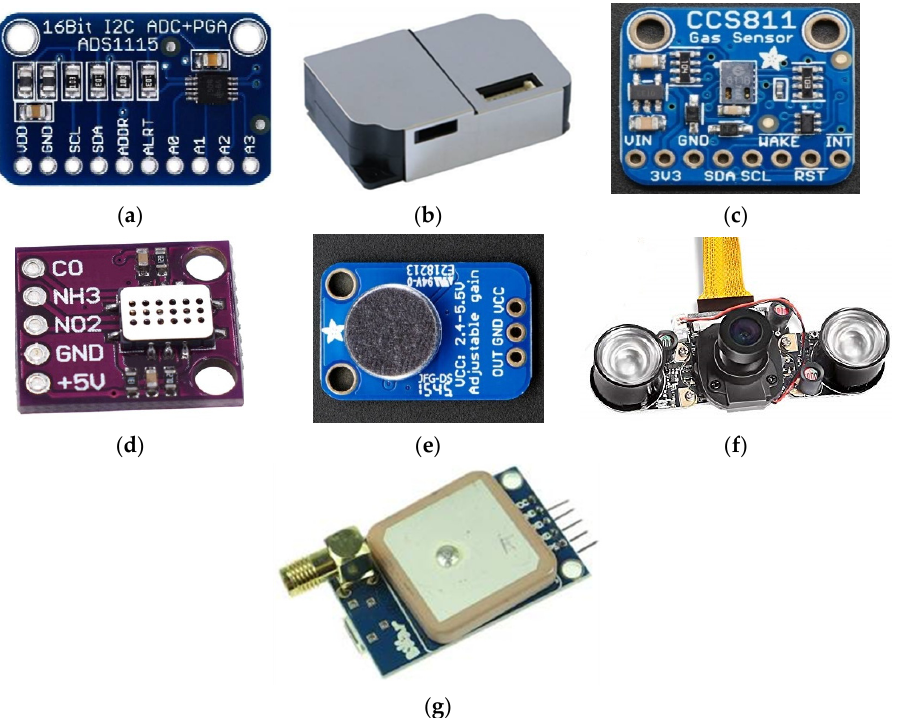
Figure 3. Modules constituting the sensing unit integrated inside the drone: AD1115 ADC module ( a ), ZH03A/B laser dust sensors ( b ), CCS811 gas sensor ( c ), MiCS-6814 sensor ( d ), Microphone sensor module ( e ), IR camera module ( f ), and NEO M8 GNSS receiver module ( g ). Additionally, the system comprises a CCS811 gas sensor to monitor the air concentration of TVOC and CO 2 ; it is an ultra-low-power digital sensor that integrates a metal oxide (MOx) gas sensor to detect CO 2 in the 400–8192 ppm and Volatile Organic Compounds (VOC) in the range 0–1187 ppb [34]. The sensor has a small microcontroller to interface; it is featured by 1.8–3.6 V supply voltage, 30 mA maximum supply current, and 80 mW maximum power consumption. Similarly, a MiCS-6814 sensor is comprised inside the developed drone; it is a compact MOS sensor with three metal oxide semiconductor sensors (Red sensor, Ox sensor, NH 3 sensor) able to detect several gas species [35]. The